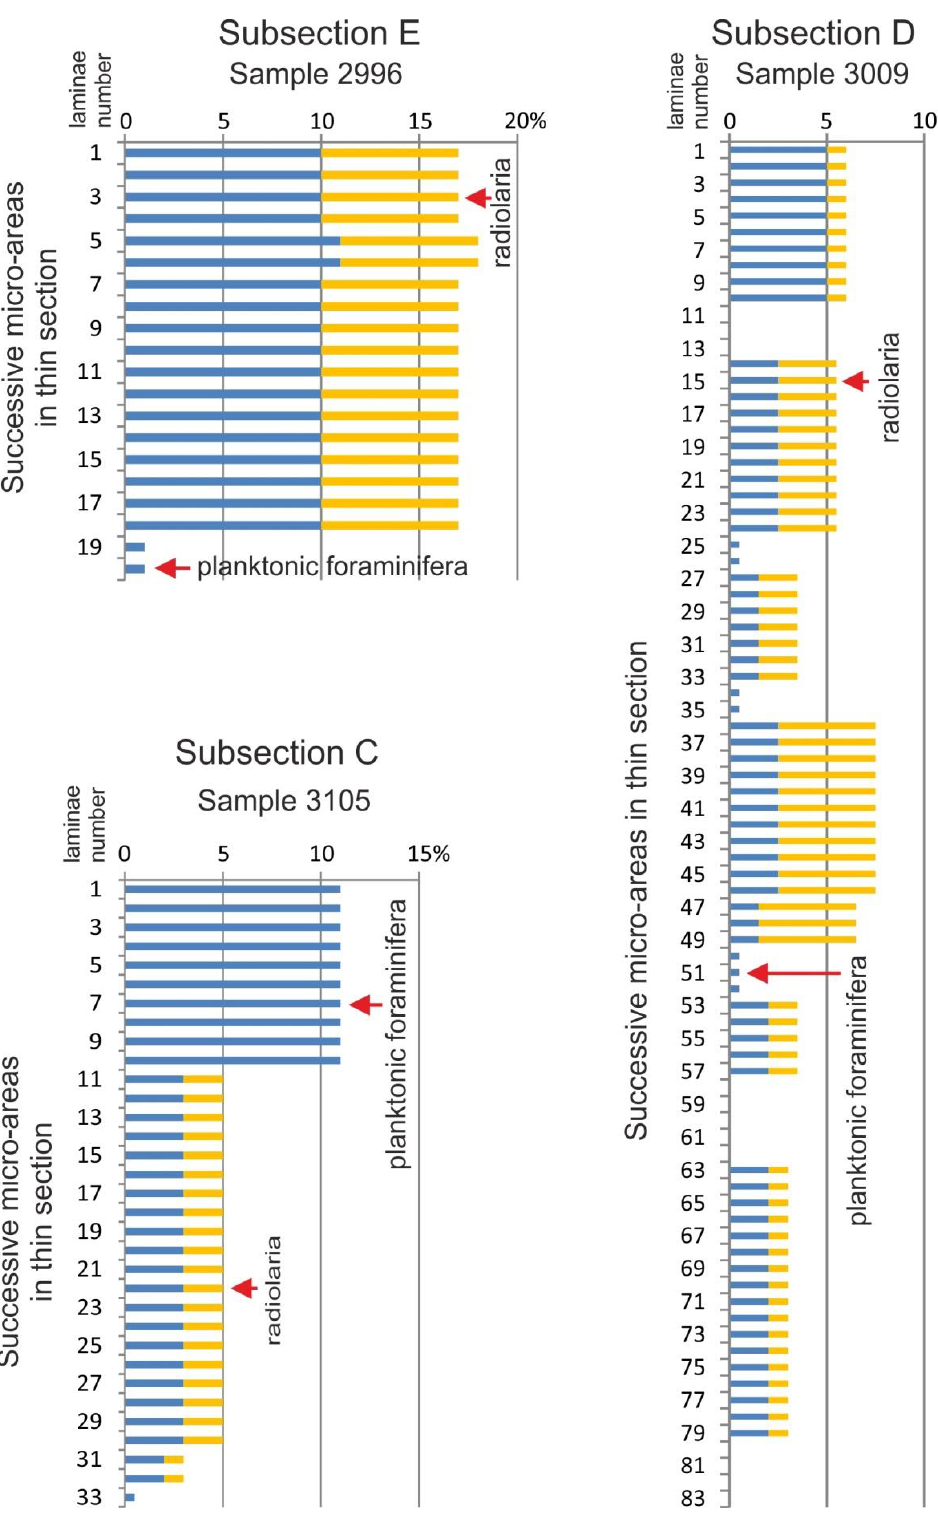
Figure 5 . Diagrams showing selected results of micro-areas analysis in subsections. Percentage abundance of radiolarians and planktonic foraminifera was estimated over the total field of view on micro-areas as subsequent laminae which vary in thickness from 0.1 to 0.5 mm.